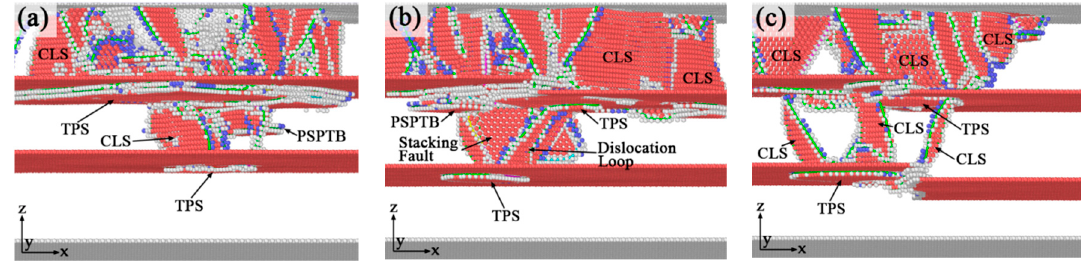
Figure 11. The formation of twinning partial slips on the lower twin boundaries in three different models. ( a ) TPT, d = 26.8 Å; ( b ) SDT, d = 22.4 Å; ( c ) TDT, d = 16.6 Å.